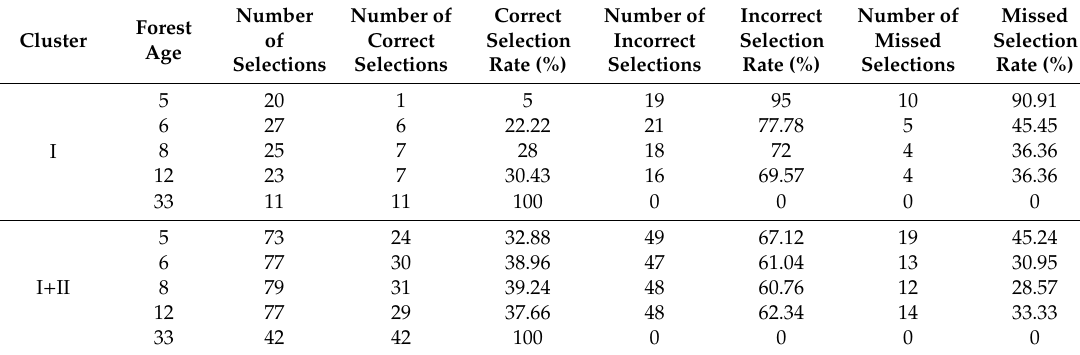
Figure 4. Distribution of excellent provenances of Chinese fir at di ff erent forest ages. The subfigure ( a – e ) shows the distribution of optimal and suboptimal provenances in 1984, 1985, 1987, 1991 and 2012, respectively. The red dots represent the optimal provenances (category I) and the blue triangle represents the suboptimal provenances (category II) selected in di ff erent forest ages. Table 6. Selection risk of the Chinese fir provenance test for di ff erent forest